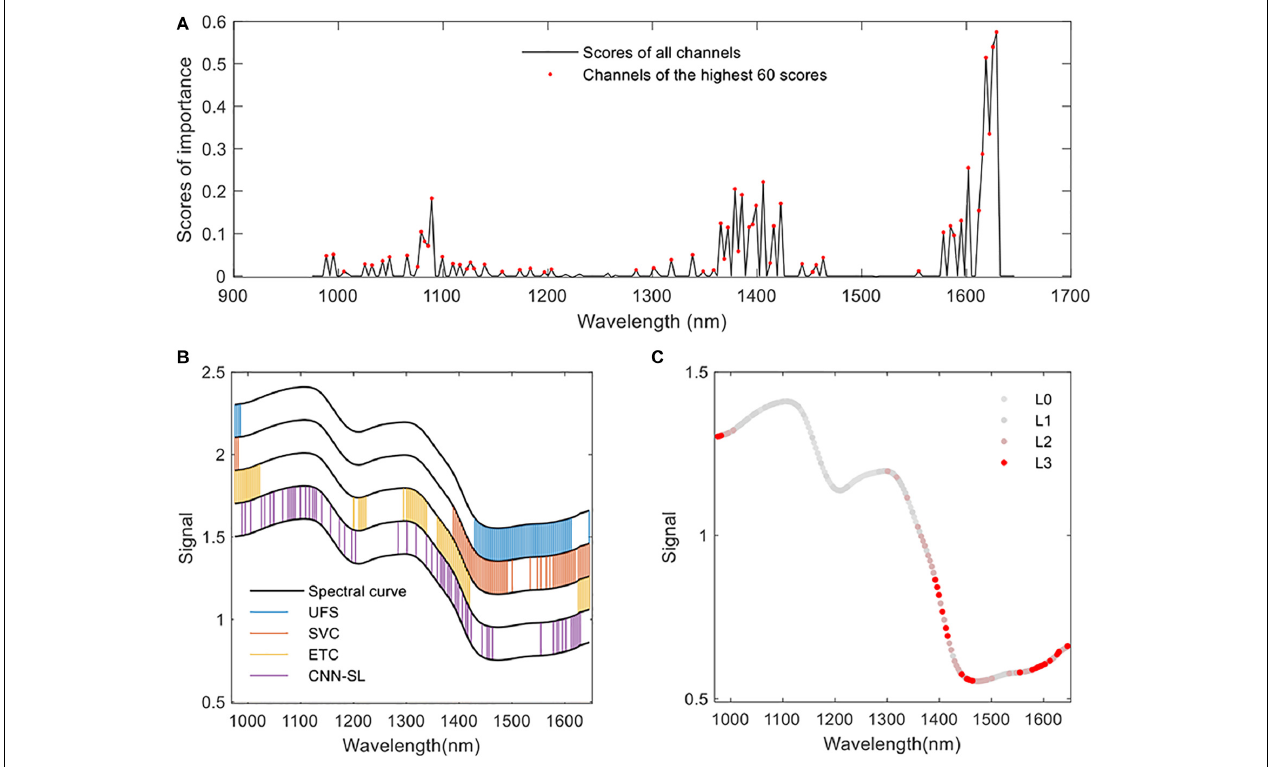
FIGURE 6 | The feature selection results. (A) The scores of each feature channels calculated by CNN-based feature selector (CNN-FS). (B) Feature selected by different algorithms. The black curves are produced by adding different offsets (0.2, 0.4, 0.6, 0.8, 1), which is only used for the convenience of visualization. The values of the y axis have no special meaning. (C) The overall result of feature selection. “L3” means that three of the four selectors find that the specific channel is important, “L2” means that two of them find the importance, and so on. The closer the color of the channel is to red, the more selectors select the channel.